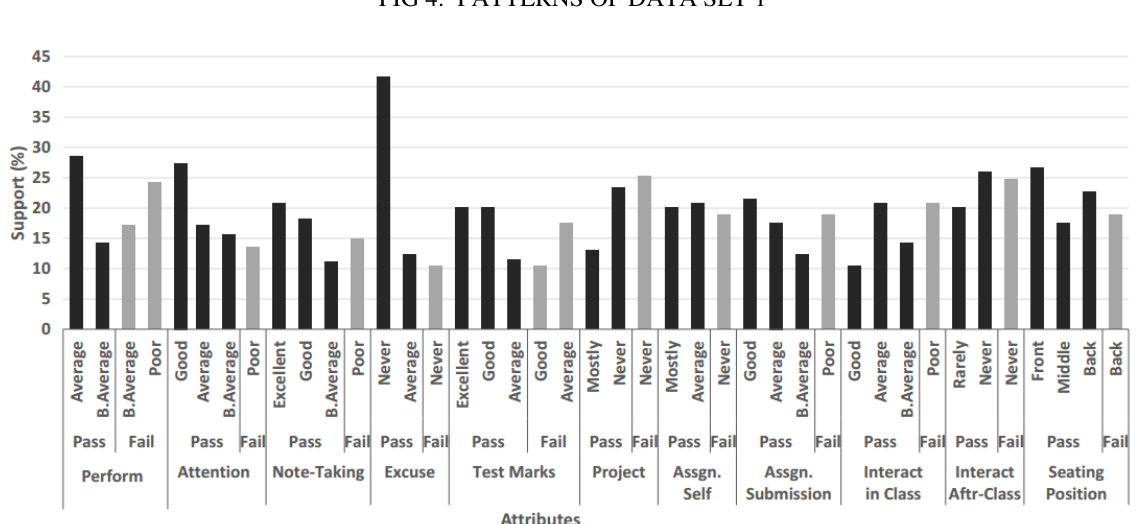
FIG.5: PATTERNS OF DATASET-2